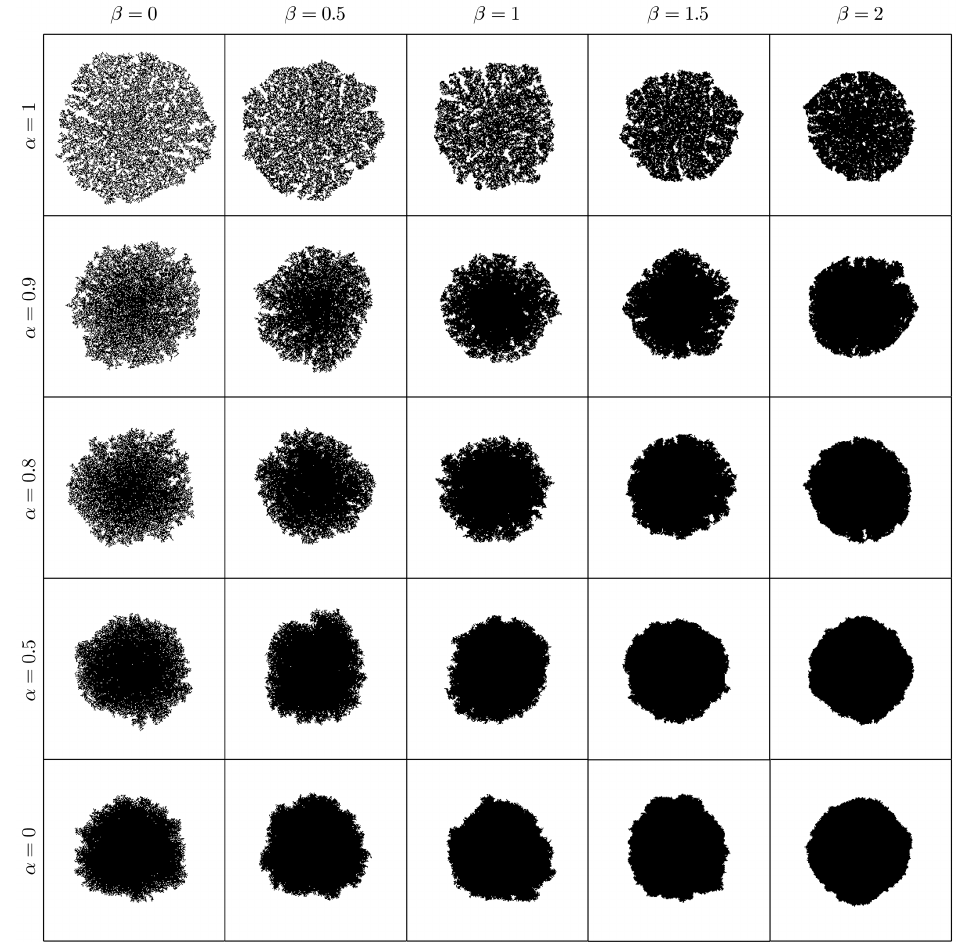
Figure 6. Shape at y = 0.25 (i.e., 25% of total occupied area, see Equation (3)) of 1 crystallization nucleus for different values of α and β , taking n = 256. The parameter β determines the “sponginess” of the crystal, and α represents the “difficulty of filling.” We have taken r inf = 32, although it is not determinant in these figures. The simulations were carried out setting C the